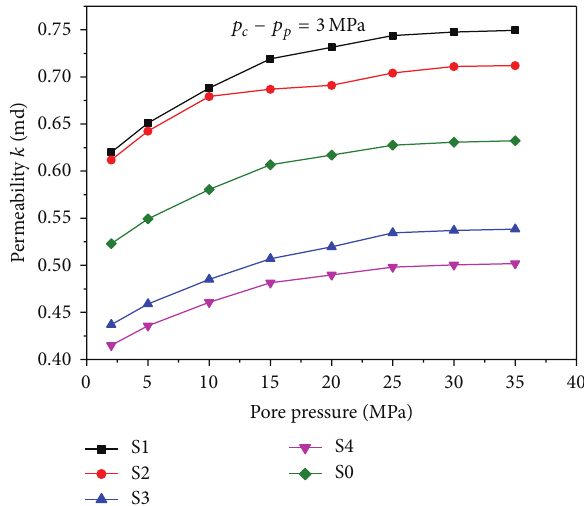
Figure 8: Permeability versus pore pressure at the condition of − 𝑝 = 3 MPa. S1, S2, S3, and S4 are simulation results; S0 is the 𝑝 𝑐 𝑝 experimental data.